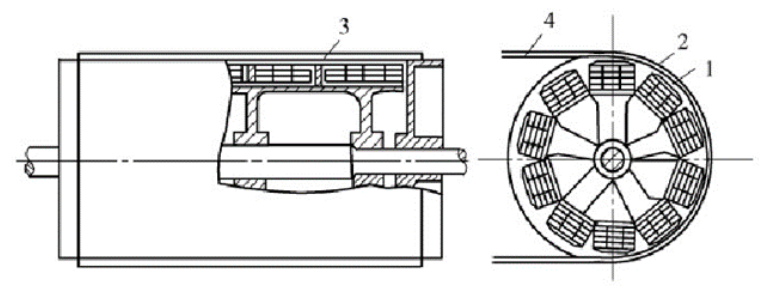
Figure 1. Schematic diagram of CT series magnetic pulley structure. 1—multipole magnetic system; 2—cylinder; 3—magnetic conductor; 4—belt [8].